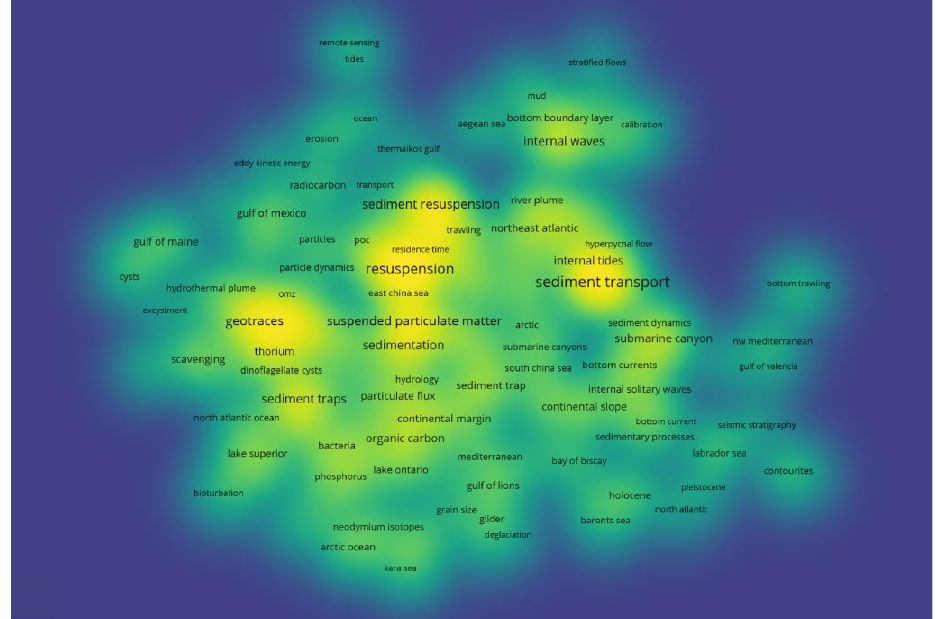
Figure 8. Keyword co-occurrence density map from 1990 to 2022 for research on nepheloid layers. A node’s color indicates the number and weight of nearby items. The closer the color of the point comes to being a brighter yellow, the more items there are around a node with higher weights. The text size denotes the number and weight of adjacent items.